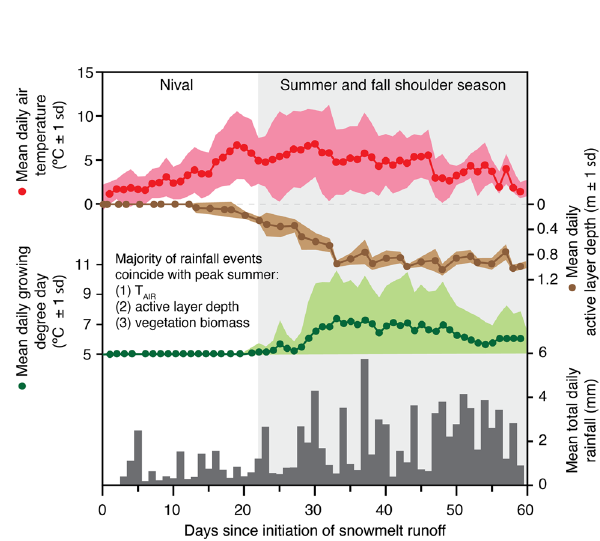
Fig. 3 Implications of the redistribution of fl uvial energy across a lengthening summer thaw season in small High Arctic watersheds (10 km 2 ) underlain by continuous permafrost. Daily mean (±1 SD) air temperature (2003 – 2019), active layer depth (2012 – 2019), growing degree day (GDD; 2003 – 2019) and total daily rainfall (2003 – 2019) from the CBAWO. A shift in higher stream powers to later in the summer/fall shoulder season enhances the potential for terrestrial-aquatic connectivity in response to rainfall inputs when annual summer air temperatures, active layer depths, and vegetation productivity are at their annual